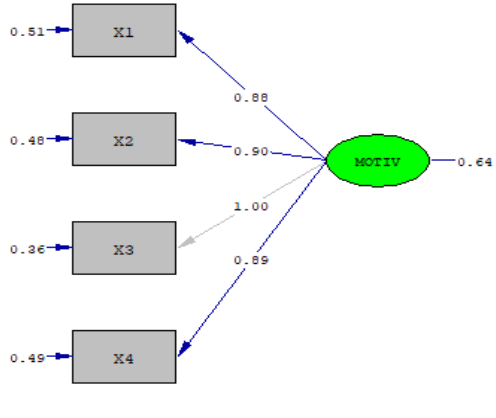
Figure 1. Measurement model of achievement motivation variable of students.